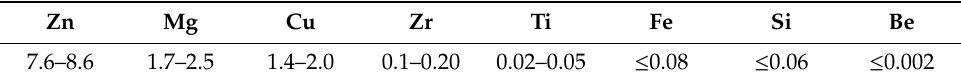
Table 1. Composition of the 7A99 aluminum alloy (wt.%).